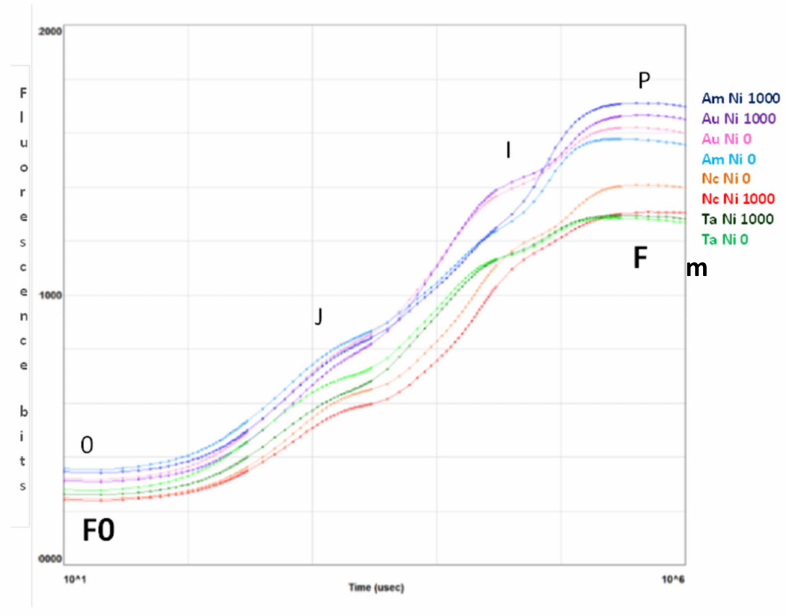
Figure 3. Fluorescence transient analysis of test species distinguished by colour of the curves (purple: A. uticulata , red: N. caerulescens , blue: A. montanum , green: T. arvense ) at Ni 0 mg kg − 1 (light colour) and Ni 1000 mg kg − 1 (dark colour). The peaks are denoted by letters 0, J, I, P and correspond to fluorescence values measured at 50 ms (F0, step 0), 2 ms (step J), 30 ms (step I), and maximal (Fm, step P). Data are the mean of ten measurements per plant. n = 100 each